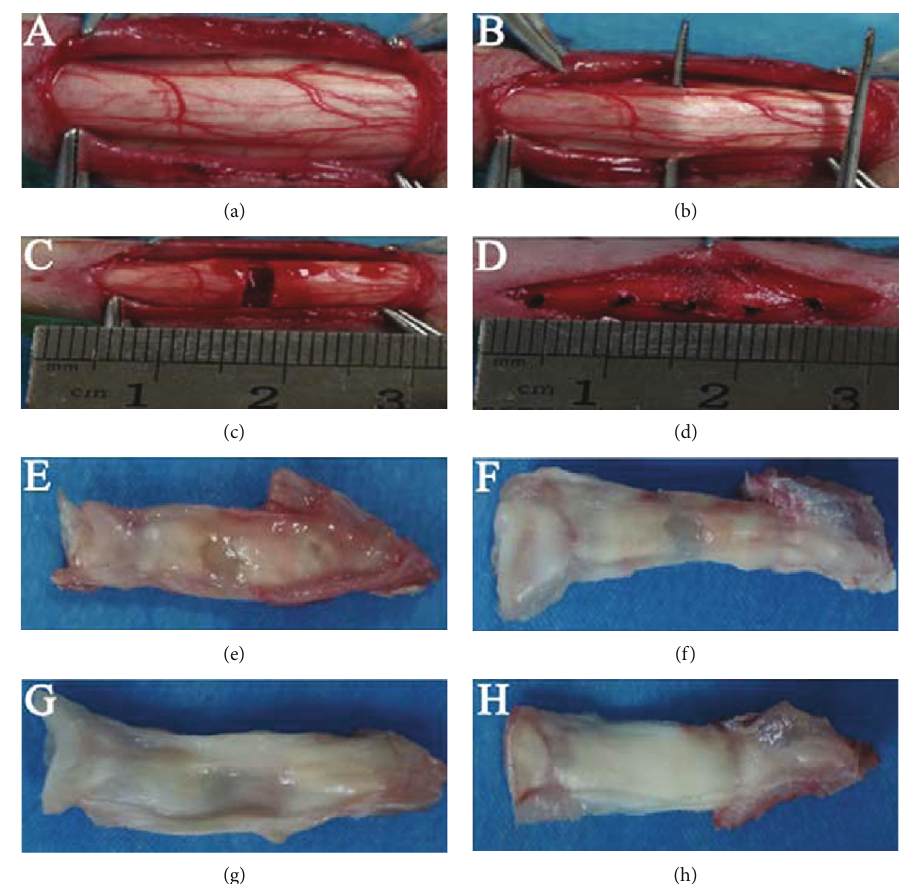
Figure 2: Surgical procedure for the patellar tendon injury model and the gross observation of specimen at 4 weeks after surgery. (a) Exposure of the patellar tendon. (b) Preparation of the middle part of patellar tendon. (c) Retraction of the broken end after severing the middle part of the patellar tendon. (d) Sutures after implanting BMSCs. (e – h) Gross observation of the PBS group (e), the normoxia group (f), the hypoxia group (g), and the control (normal) group